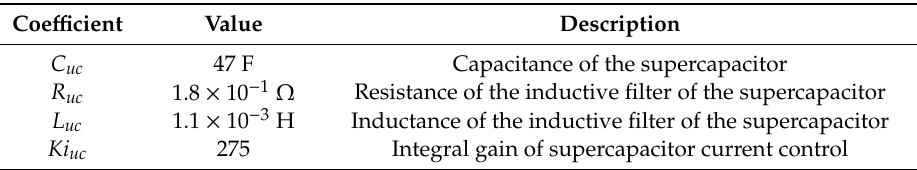
Table 2. Parameters of the SC storage system.